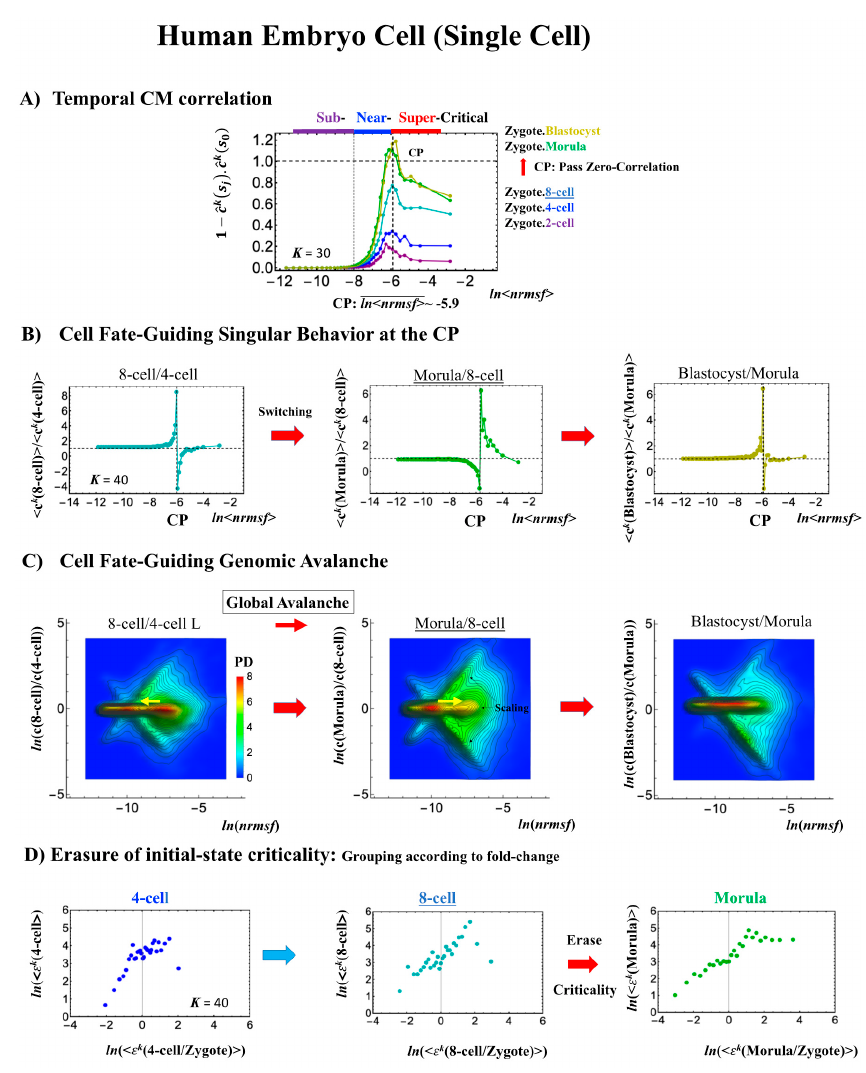
Figure 7. Human embryonic development (single-cell). The CP corresponds to ( A ) the peak of temporal CM correlation (see the di ff erence from the cell population in Figures 4A and 5A). A complete erasure of the zygote-CP (genome attractor) occurs after the 8-cell state ( K = 30: n = 555 RNAs). Distinct response domains (critical states) as manifested in temporal CM correlations are shown (red: super-critical; blue: near-critical; purple: sub-critical), where the location of the CP lies at the boundary between near- and super-critical states. ( B ) Switching singular transition at the CP ( K = 40: n = 416 RNAs) occurs at each cell state change (only shown from the 4-cell state here). The bimodal folding-unfolding feature at the CP suggests the occurrence of intra-chain segregation in the transition for genome-sized DNA molecules (see more in Section 3.2). ( C ) A genome avalanche occurs as a traveling density wave along low-expressed genes (around non-fold change: y = 0; the yellow arrow indicates the next direction of travel). Furthermore, three distinct scaling behaviors (linear behaviors in the density profiles in the log–log plot) emerge, which reveals that coordinated chromatin dynamics emerge to guide the reprogramming process. ( D ) The erasure of zygote criticality after the 8-cell state coincides with the timing of ( A ) the zero temporal CM correlation through ( B ) a switching singular transition at the CP. This timing further matches the timing of coherent perturbation of the genome engine passing through the non-equilibrium fixed point (see Section 2.6). Note: A linear behavior emerges in the grouping of randomly shuffled whole-genome expression, as expected; therefore, higher nrmsf is associated with higher expression (see more in Figure 3D in [7]).